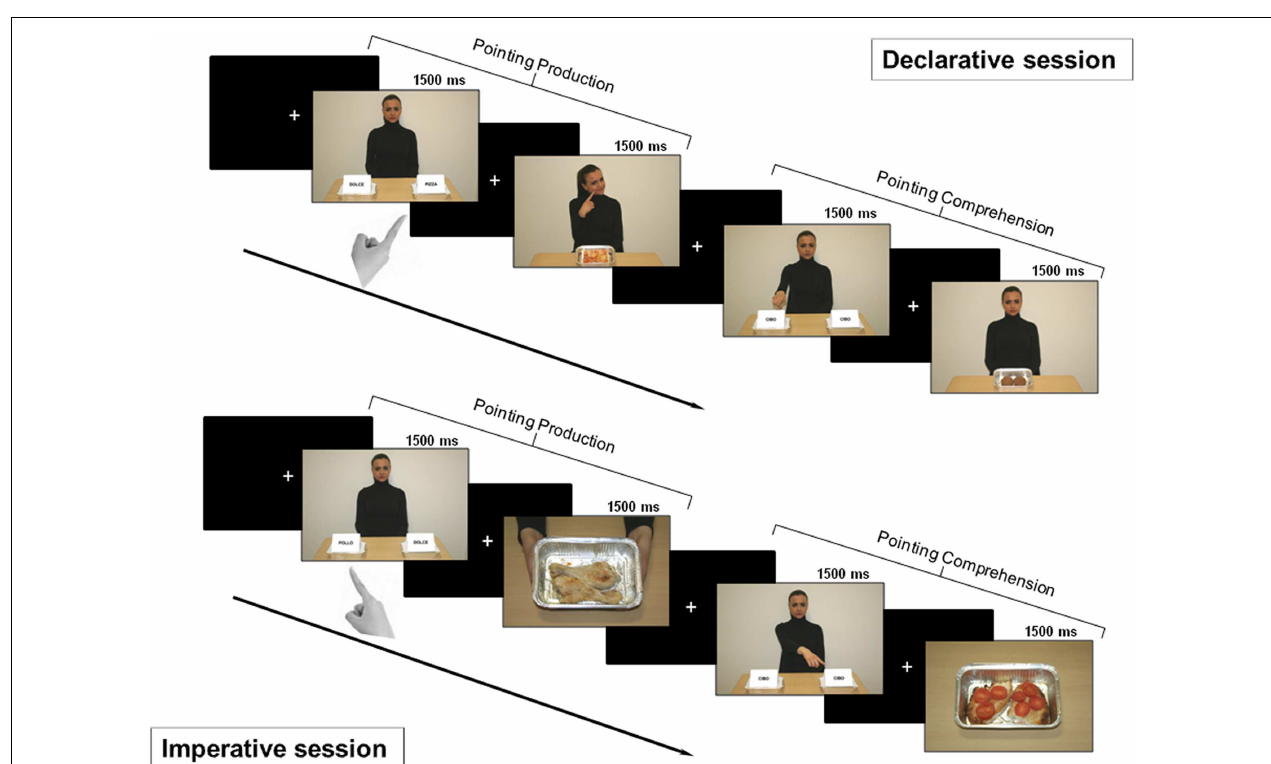
right of the panel, based on the side of the pointed food; if subject did not, no button had to be pressed. Bottom: imperative session . First part: after a fixation cross, a picture for pointing production was shown for 1500ms. Subjects were asked to make an imperative pointing toward the tray containing the salty food.Then, a positive or negative feedback was given to the subject (two hands offering a tray with the pointed food or empty, respectively). Second part: after a fixation cross, a picture for pointing comprehension was shown and subjects were asked to carefully observe which tray the character was pointing to. If the food was available (full tray), the subject had to press the button corresponding to food side (left or right); otherwise (empty tray) no button had to be